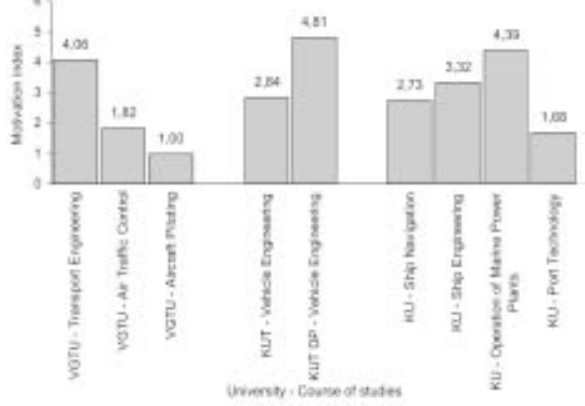
Fig 11. Motivation indexes of full-time studies in transport engineering courses in